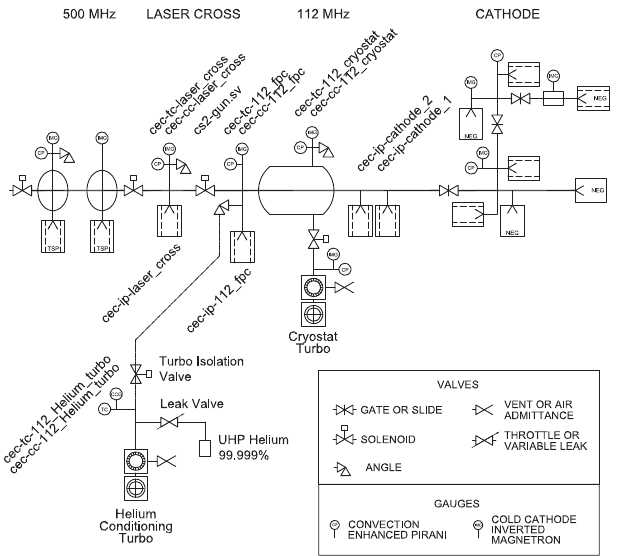
FIG. 4. Schematic of the clean He gas delivery system for the conditioning of the CeC SRF cavities. Here ip ¼ ion pump; tc ¼ thermal conductivity gauge; cc ¼ cold cathode gauge; sv ¼ vacuum valve; NEG ¼ nonevaporable getter pump; UHP ¼ ultrahigh purity grade.